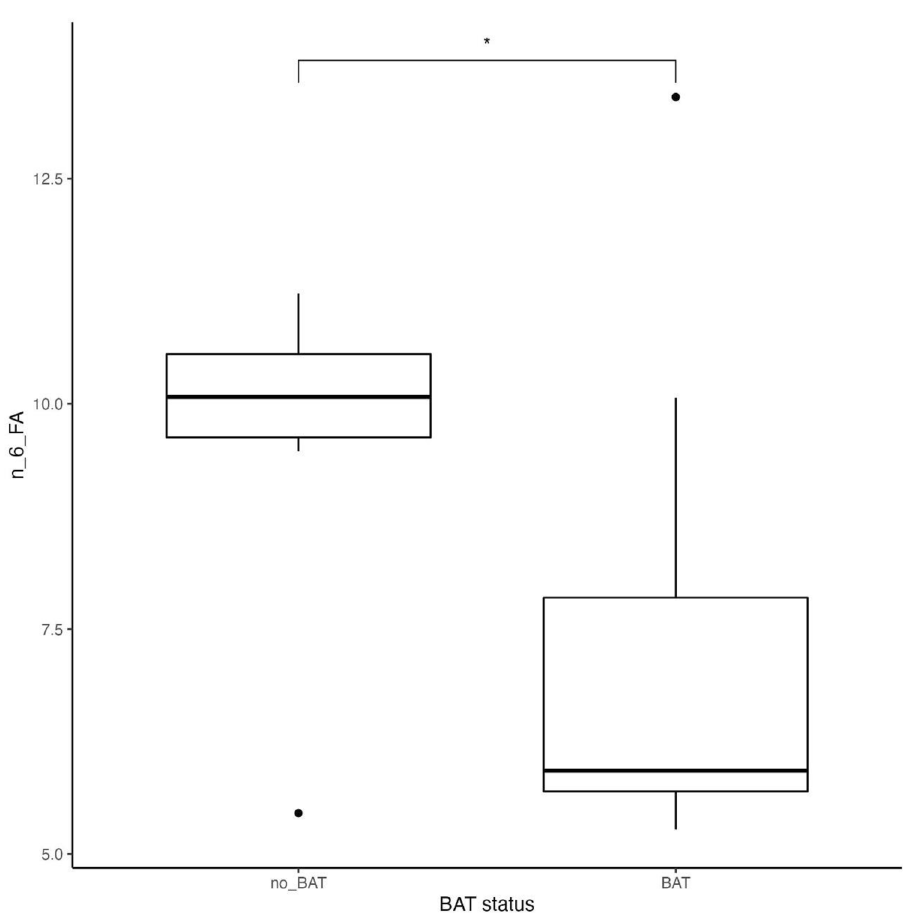
Figure 3. Omega-6 FA intake in subjects dependently on BAT status (p =